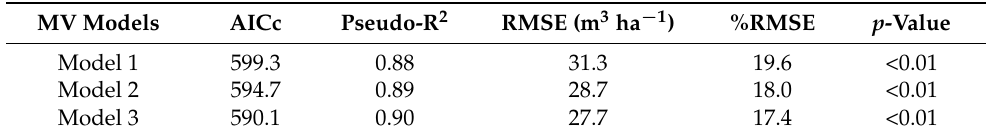
Table 5. Comparison of merchantable volume (MV) models built before or after a point cloud filtering. MV Models AICc